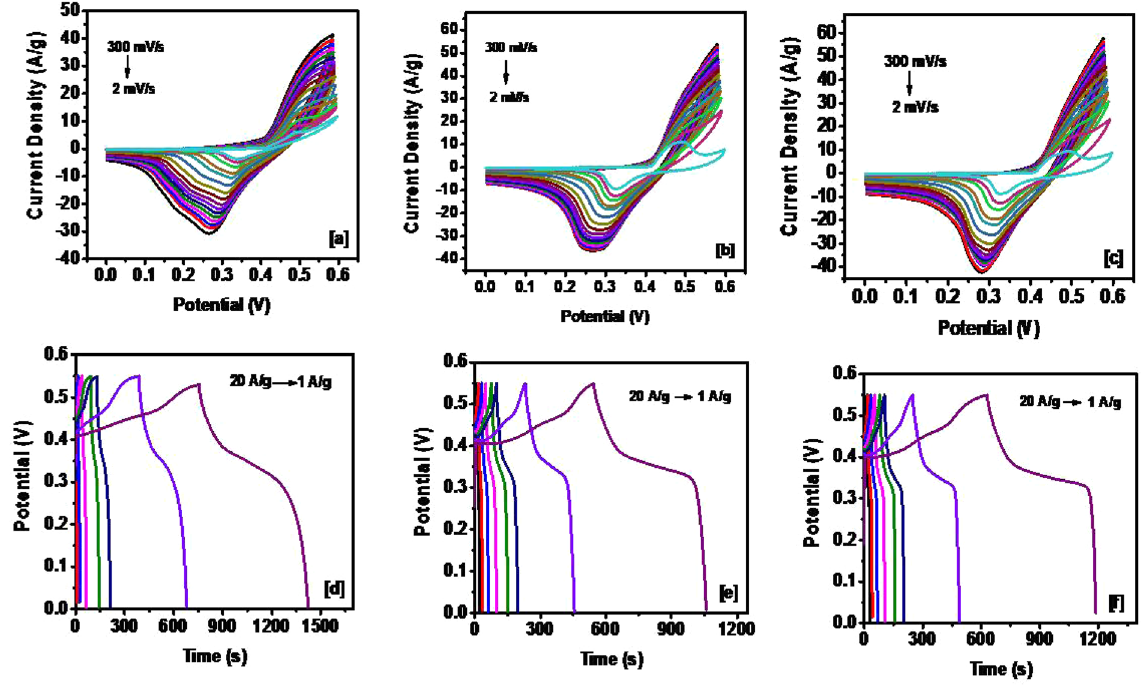
Figure 6. CV curves at various scan rates for NiS synthesized from the complex (1) at ( a ) 200 °C, ( b ) 300 °C and ( c ) 400 °C. Galvanostatic charge and discharge curves of NiS synthesized from the complex (1) at ( d ) 200 °C, ( e ) 300 °C and ( f ) 400 °C.